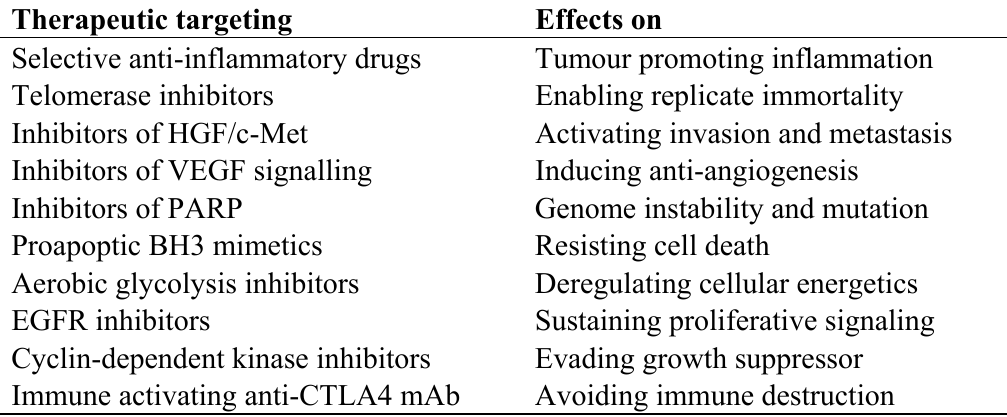
Table 1. The selected therapeutic targets designed for the cancer